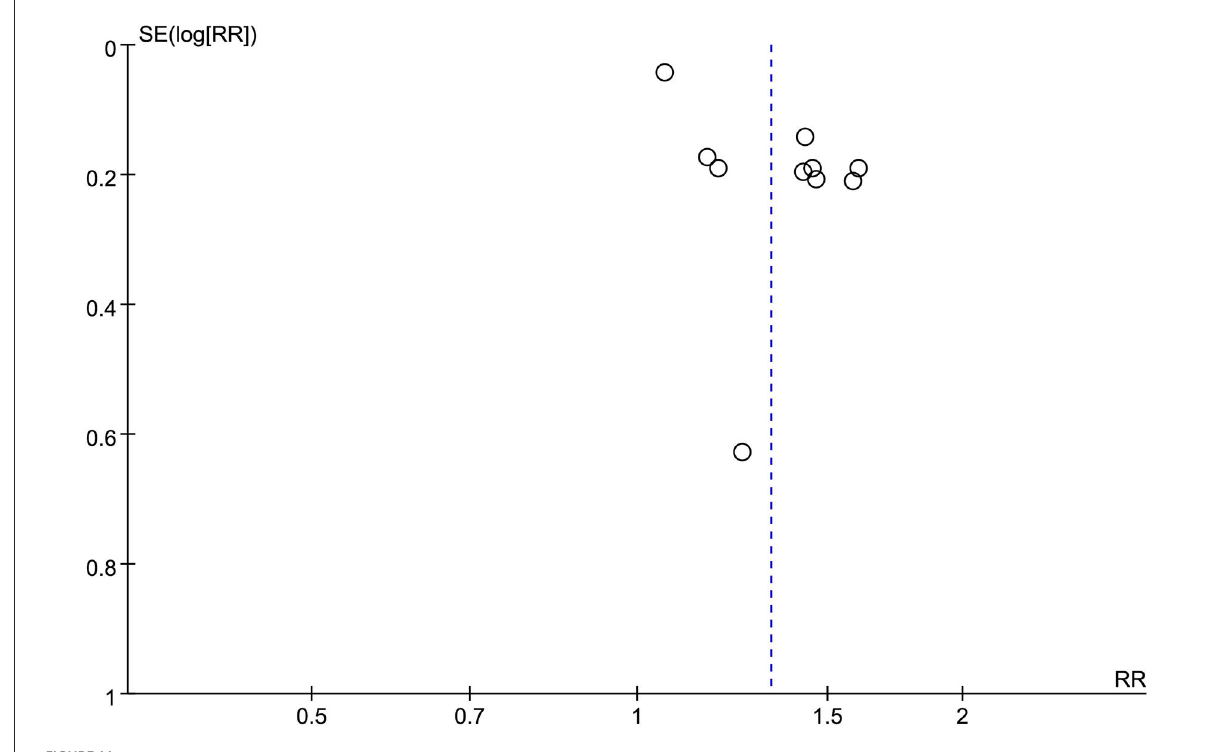
FIGURE11 Efficient publication of biased funnel